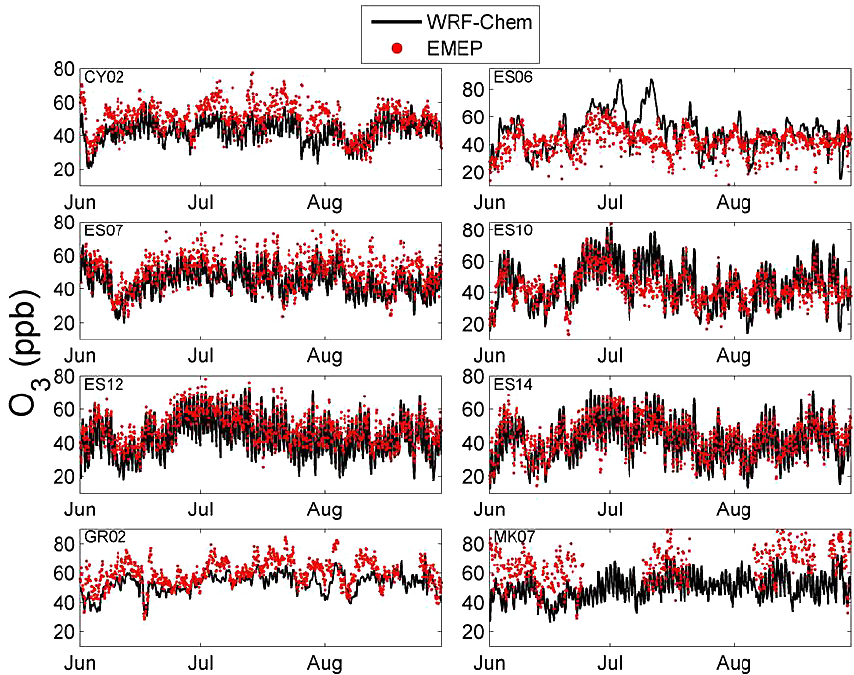
Figure 6. O 3 time series of EMEP and WRF-Chem data at the surface for the stations localized in Fig. 2 for the period JJA 2010.